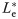
Finding the least squares estimate (LSE) Le* for animal RQ5427 by fitting the simulated Yz to the experimental Y^z.The values of (λ, Ch, rn) are chosen to be (0.99, 500, 2.5). Simulations with {hi} set to {y^i}Hss+ instead of drawing from P(h) generate similar results. (a) The LSE is Le*=23.4. Averages and standard deviations (error bars) of the 200 MSEs are plotted. (b) Comparisons between the experimental (solid) Y^z and simulated (dashed) Yz with fixed Le*=23.4. The error bars are determined by considering the standard deviation of the average abundances (yi or y^i) of all clones exhibiting z absences.